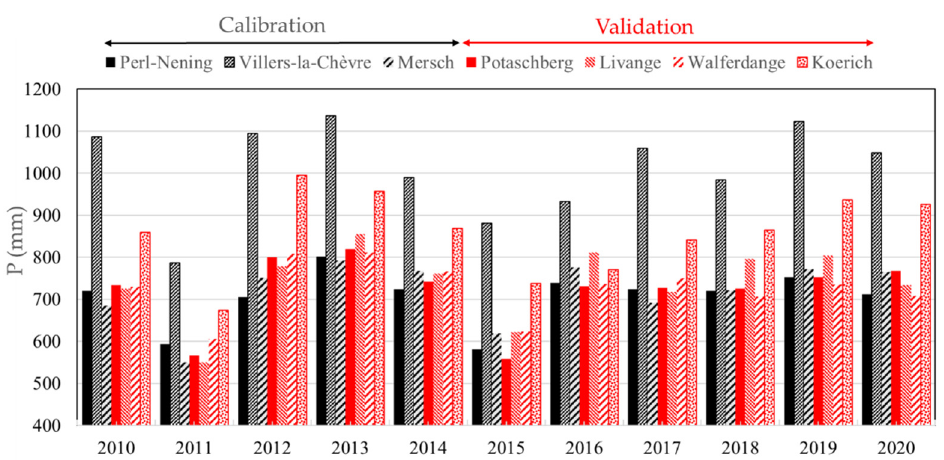
Figure 2. Annual rainfall of calibration and validation stations.